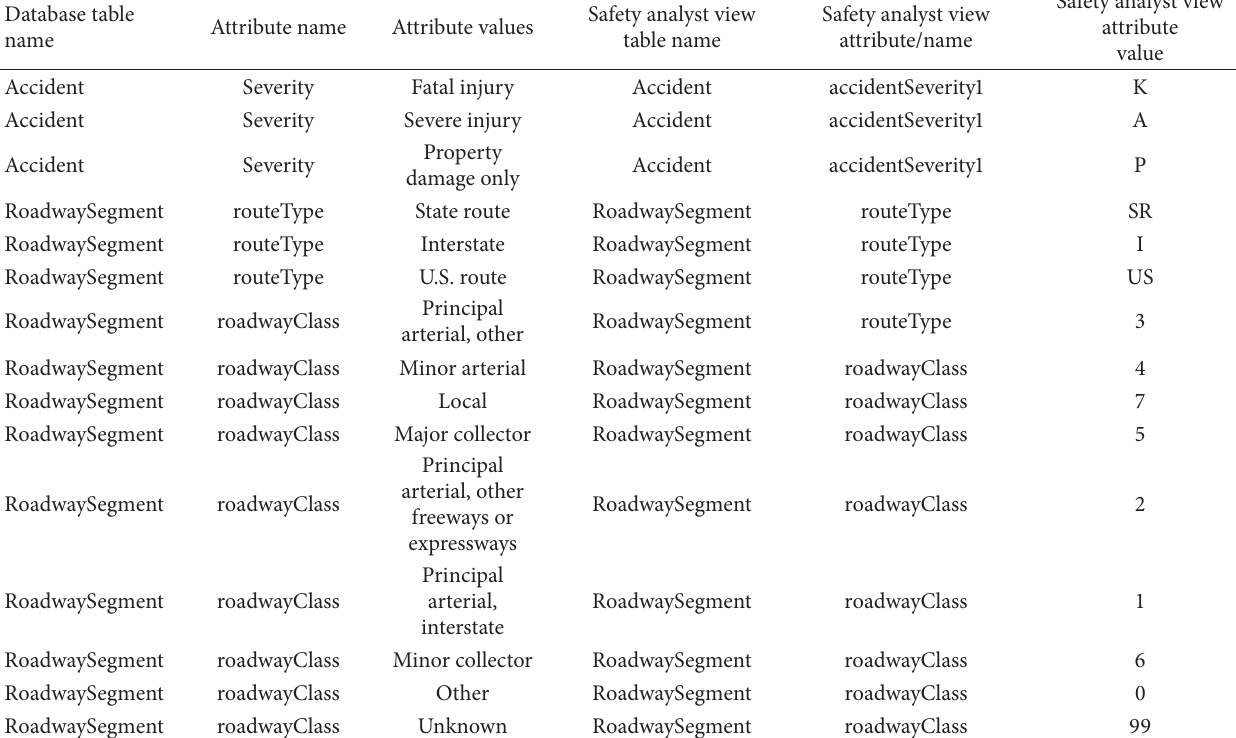
Table 3: Mapping between a general and the safety analyst